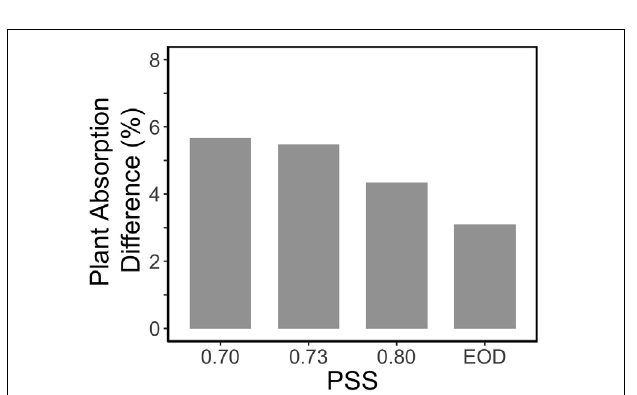
FIGURE 6 | Relative impact of internode length on the calculated light absorption of tomato plants in an extended canopy (no presence of vertical screens). The tomato plants had a default plant architecture of the PSS 0.88 treatment, and only the parameter internode length was changed by taking the internode length values from plants with PSS 0.70, 0.73, 0.80, and EOD.